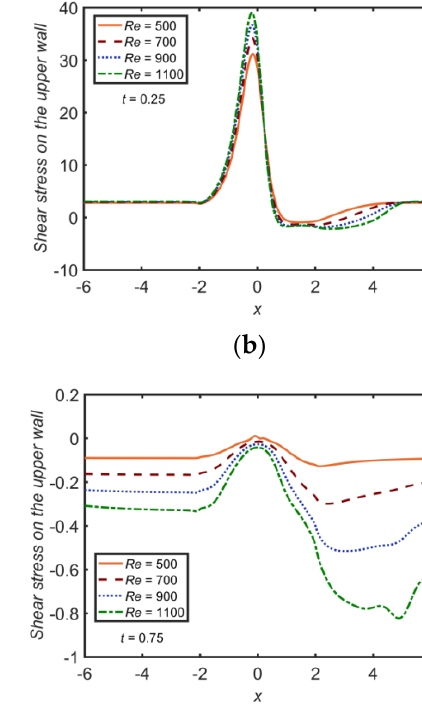
Figure 6. The WSS distribution on varying the values of K with M = 5, St = 0.02, and Re = 700 at ( a ) t = 0, ( b ) t = 0.25, ( c ) t = 0.50, and ( d ) t = 0.75.